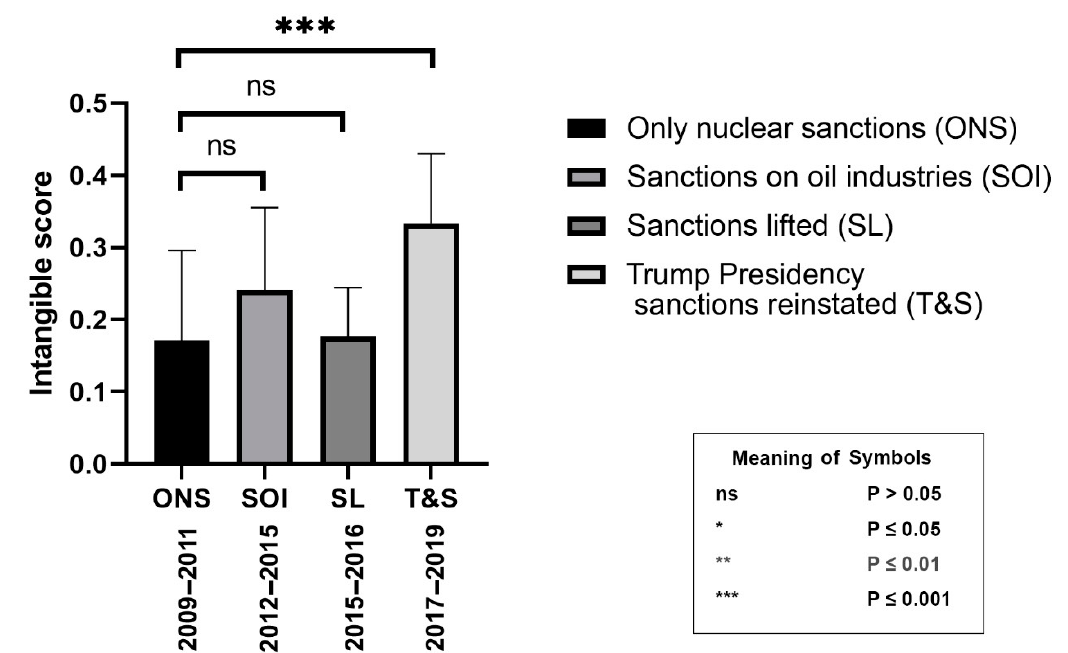
Figure 7. The relationship between the sanctions and intangible score in Tehran, 2009–2019.